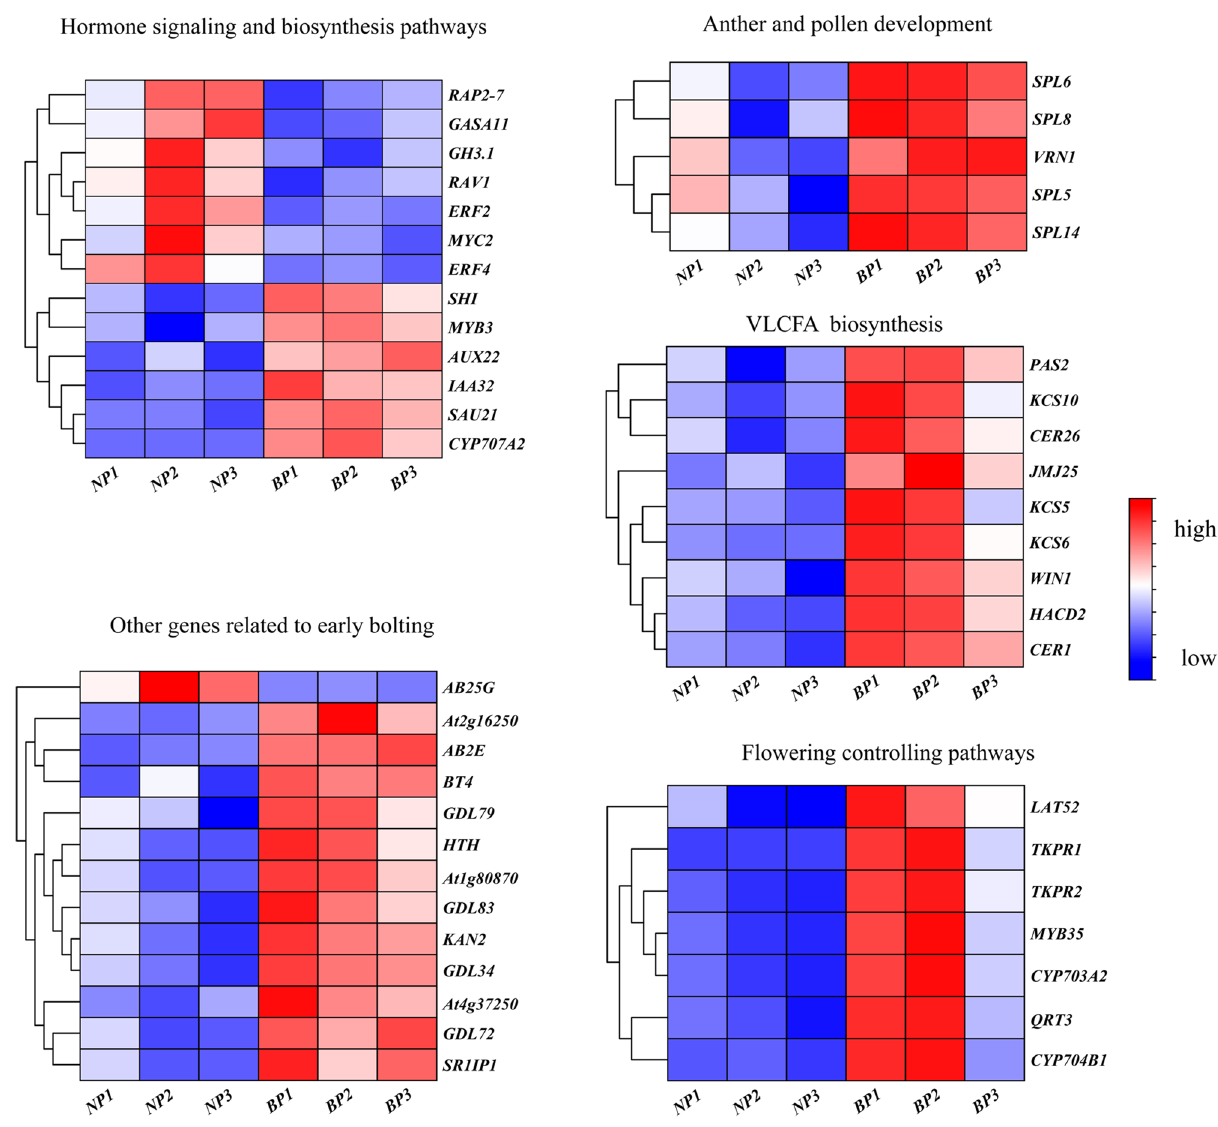
Figure 4. Heatmap of DEGs putatively involved in early bolting between BP and NP. Differential gene expression is based on FPKM values. Gene comparison table from A. sinensis to Arabidopsis thaliana are provided in Supplementary Table